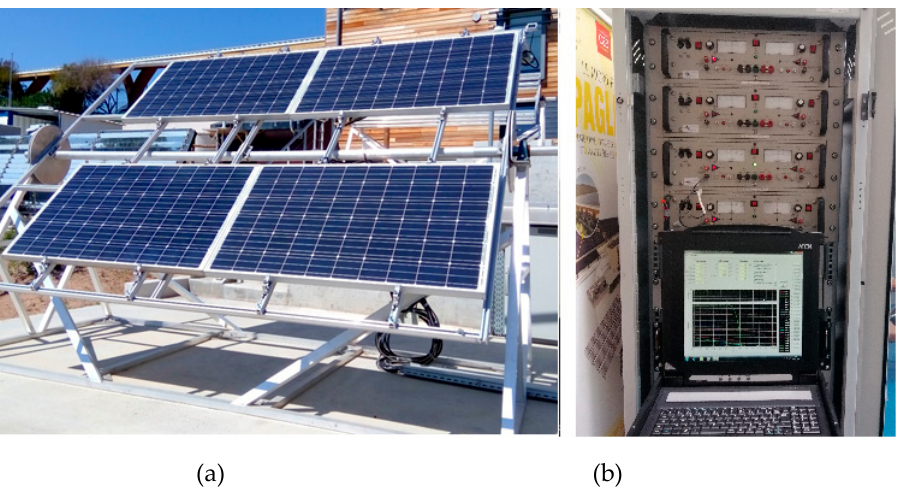
Figure 1. The four Tenesol modules ( a ) and the acquisition and curve display system ( b ).